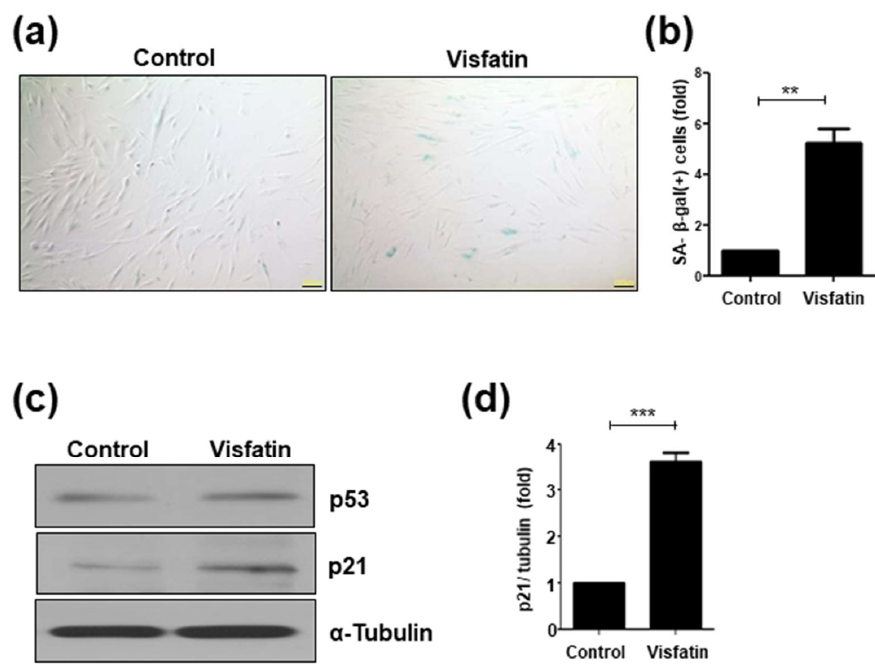
Exogenous visfatin treatment increases the senescence of human dental pulp cells (hDPCs). hDPCs were incubated with visfatin (500 ng / mL) for 24 h. ( a ) Representative image of senescence-associated (SA)- β -galactosidase staining. Scale bar: 200 µ m. ( b ) Quantification of the percentage of SA- β -galactosidase positively stained cells. ( c ) Western blot analysis for detecting p53 and p21 proteins. α -Tubulin was used as the loading control. ( d ) Densitometric analysis for assessing relative p21 protein levels normalized to α -Tubulin protein levels. ** p < 0.01, *** p < 0.001.